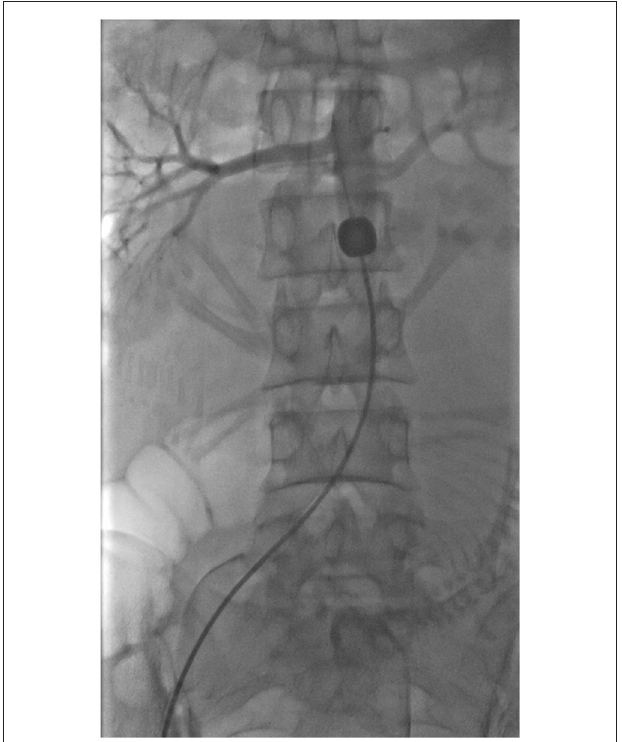
FIGURE 3 | Image of the balloon. The balloon was placed into the distal abdominal aorta beneath the opening of the renal arteries.